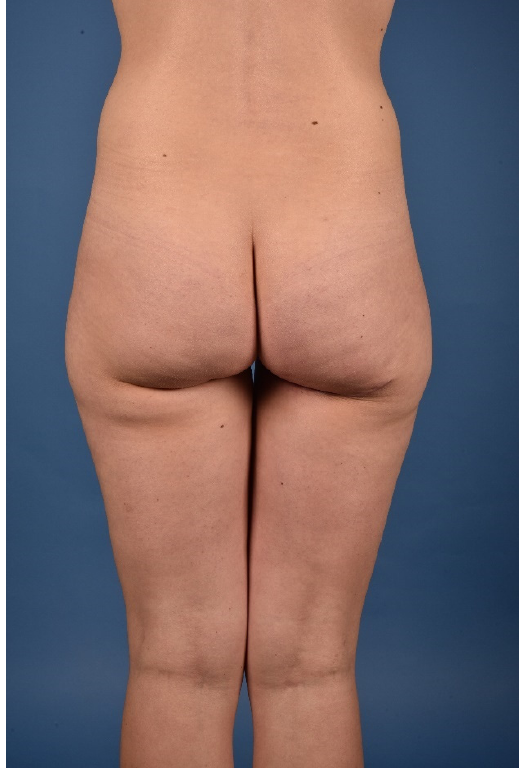
Figure 7. Postoperative donor site image.